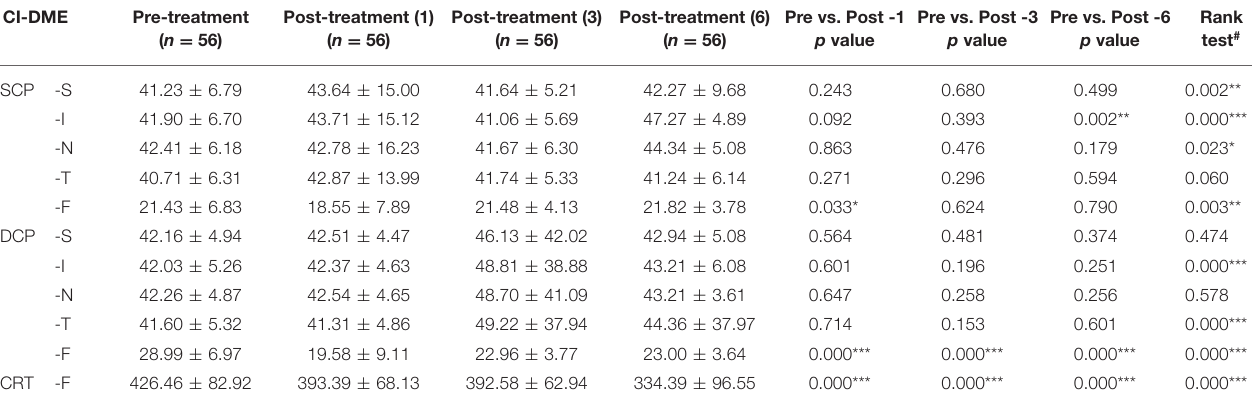
TABLE 2 | The change vessel density of superficial retinal capillary plexus and deep retinal capillary plexus after conbercept treated CI-DME for 1, 3, and 6 months, compared to pre-treatment.